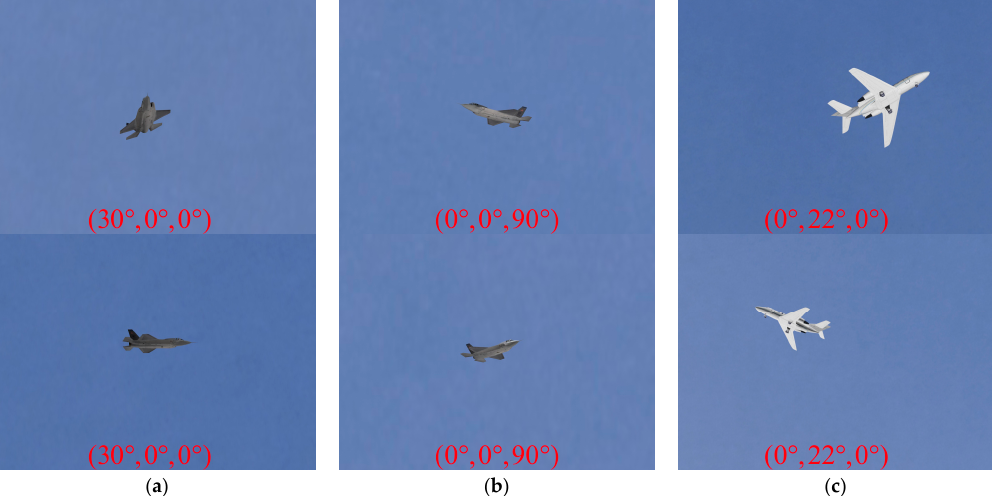
Figure 11. Synthetic image pairs generated in different scenes: ( a ) an image pair of F35 model in scene 1; ( b ) an image pair of F35 model in scene 2; ( c ) an image pair of Cessna model in Scene 3.